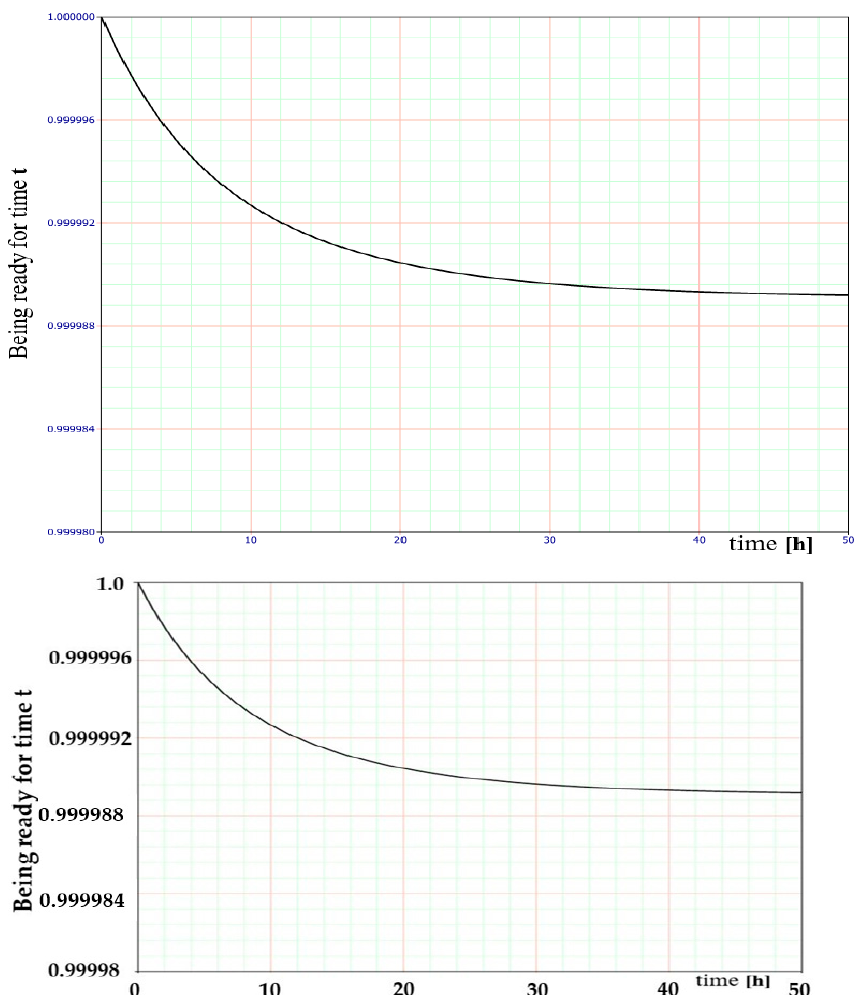
Figure 10. Graphs of availability for individual states of an FAS with smoke exhaust based on com- mon fire detection in the S 0 state over time [printout from the BlockSim software]. Table 1. Calculations of the FAS availability and reliability coefficients for the S 0 state.